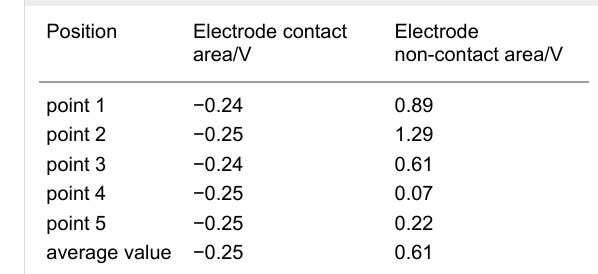
Table 1: Electrical potential of points within the electrode contact after charging for 2 min at 2000 V and points within the non-contact